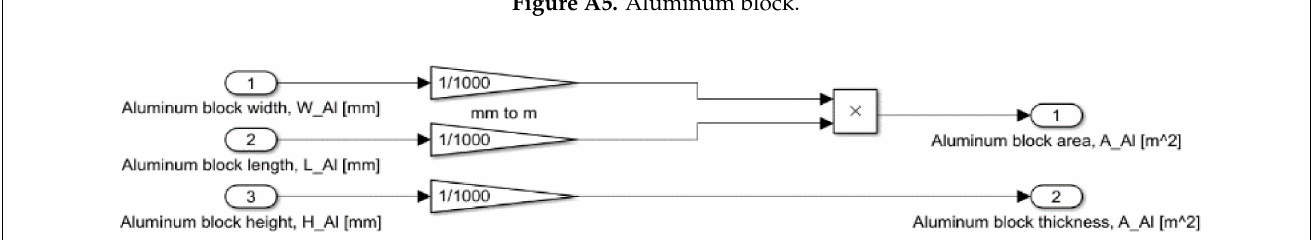
Figure A6. Aluminum